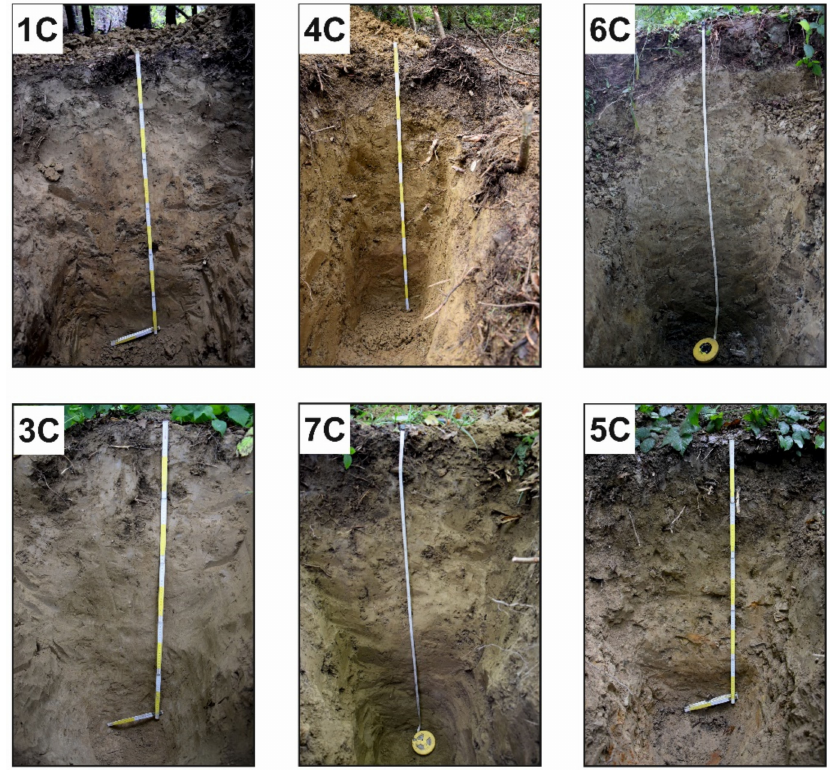
Figure A1. Exemplary reference soil profiles. Numbers refers to study plots and study sites distribu- tion presented at Figure 1. Soil profile depths: 1C—125 cm; 4C—130 cm; 6C—140 cm; 3C—105 cm; 7C—150 cm; 5C—105